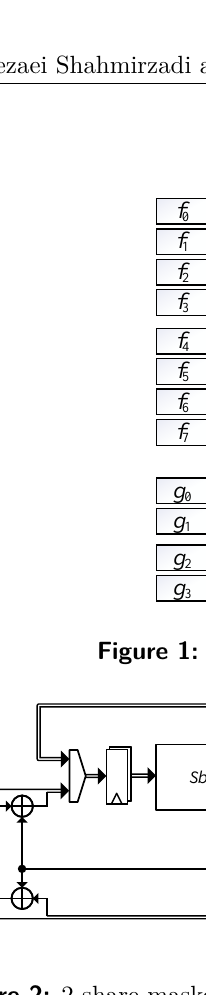
Figure 2: 2-share masked round-based Midori-64 enc/dec without any fresh